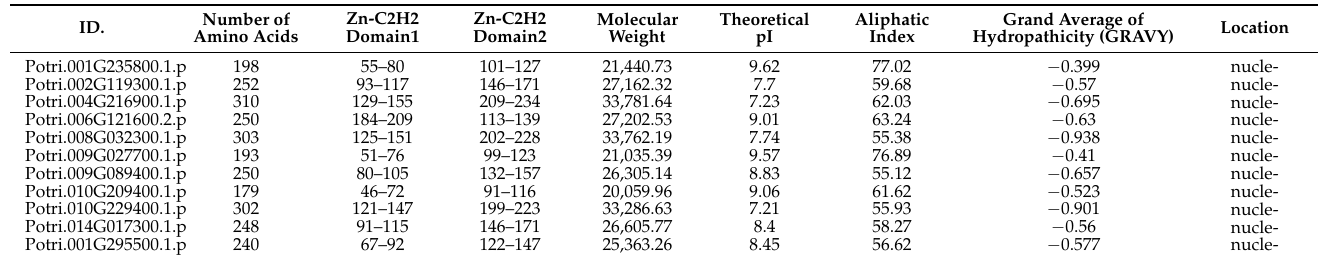
Table 1. Characteristics of PtriZAT